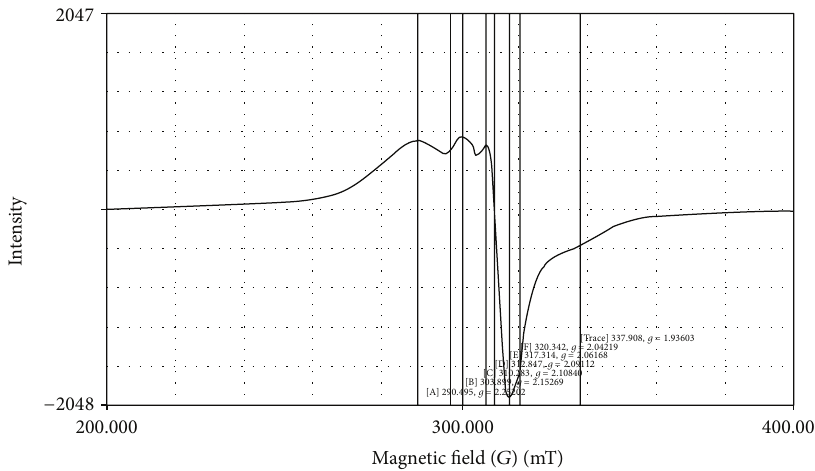
Figure 2: The ESR spectrum of [Cu(DMIIMBP)(phen)ClO 4 ].